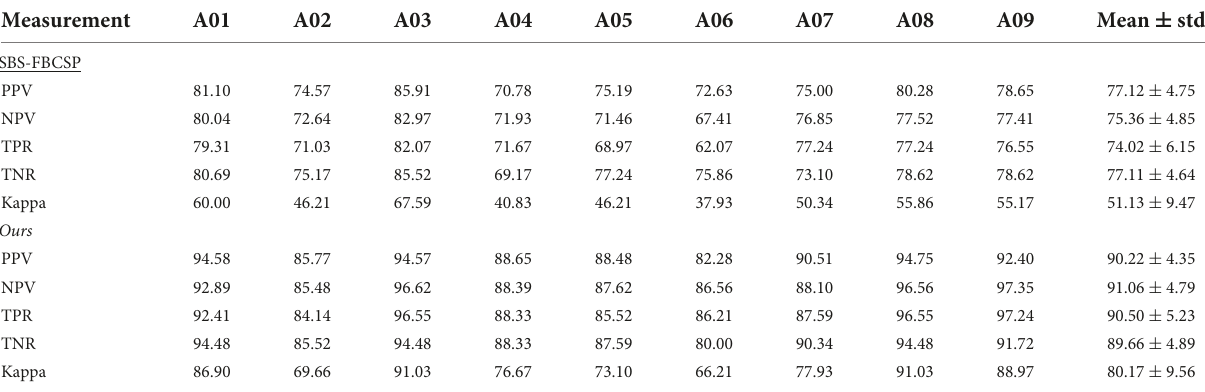
TABLE 5 Performance comparison between SBS-FBCSP and our method, using dataset 1. Measurement